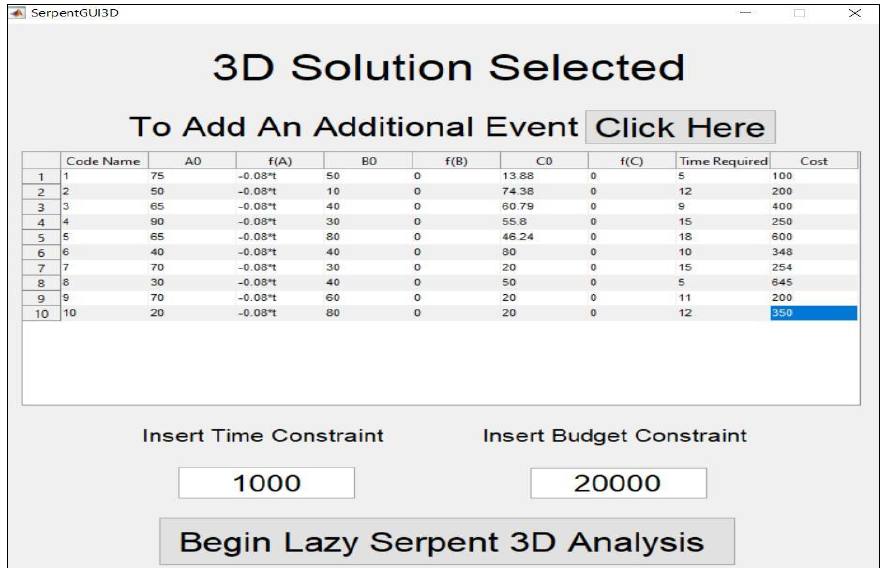
Figure 10. Lazy serpent software interface input.